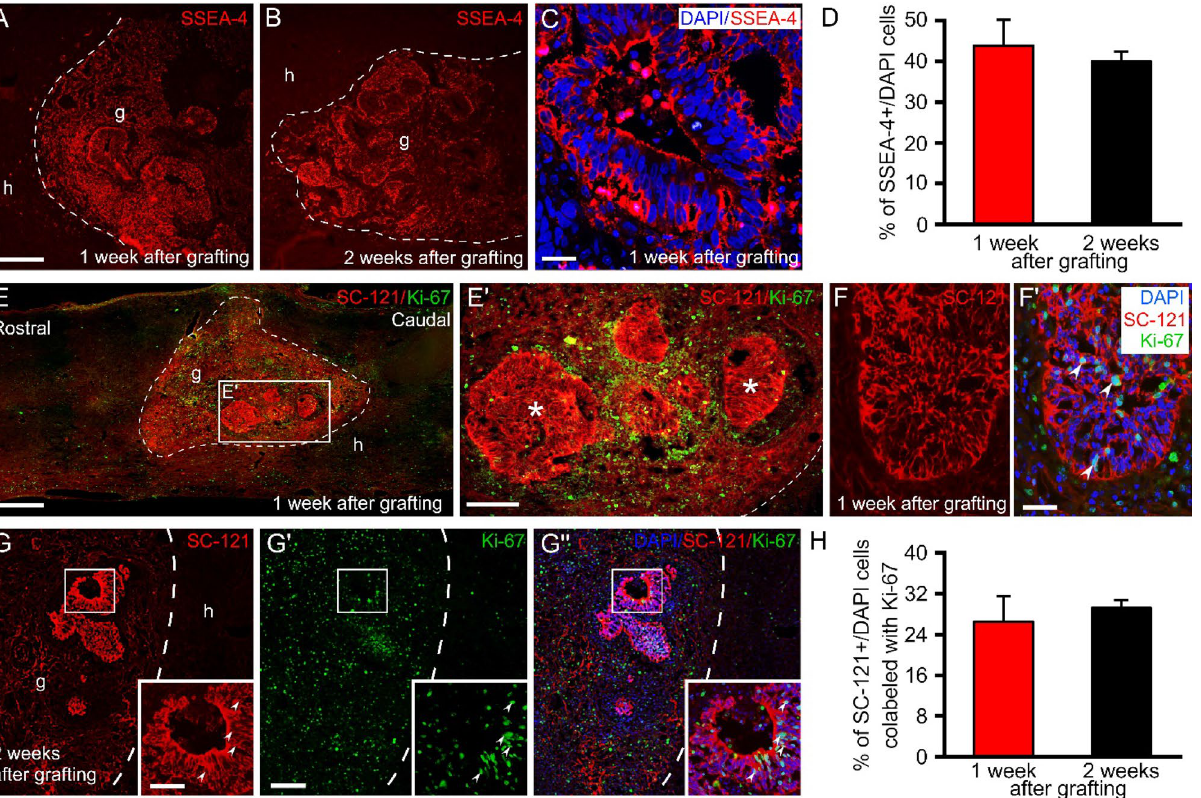
Figure 5. Transplanted hiPSCs proliferate within the injured spinal cord. Low and high-power images show the extent of hiPSC survival within the injured spinal cord 1 and 2 weeks after transplantation. (parasagittal sections A – G ′′ ). ( A – C ) Expression of the embryonic stem cell marker SSEA-4 by the grafted hiPSCs 1 and 2 weeks after transplantation. ( D ) Cell quantification proved that the engrafted hiPSCs had a pluripotency fate identified by SSEA-4 expression (44.5% ± 5.1 and 40% ± 2.4; 1 week or 2 weeks after grafting, respectively). ( E ) The grafted hiPSCs displayed high Ki-67 positivity in the contusion cavity 1 and 2 weeks after grafting. ( E ′ ) Some engrafted hiPSCs form clusters (asterisks) while others remained dispersed. The enlarged figures in F and F ′ show the grafted hiPSCs (SC-121 + , in red) with their DAPI-labeled nuclei, out of these many display Ki-67 positivity (green). ( G – G ′′ ) The transplanted cells (SC-121, red) showed high proliferative capacity (Ki-67, green) 2 weeks after transplantation. Arrowheads in the boxed area point to Ki-67 + nuclei associated with SC-121 + cells within the cluster. (H) Bar diagram shows the proliferative activity of grafted hiPSCs. Note that 26.5% ± 5.5 and 29.2% ± 1.5 (1 week or 2 weeks after grafting, respectively) of SCS-121 + hiPSCs were positive for Ki-67. Data are expressed as mean ± SEM. (n = 4 in each time point) h , host; g , graft. Scale bars: ( A ) 250 µm, ( C ) 25 µm, ( E